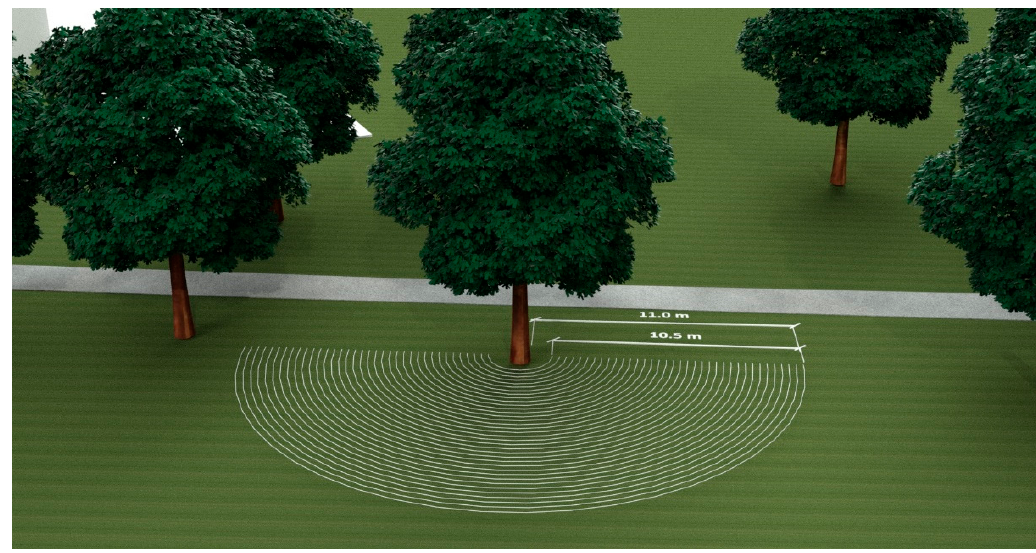
Figure 3. Rendering of the GPR survey setup.